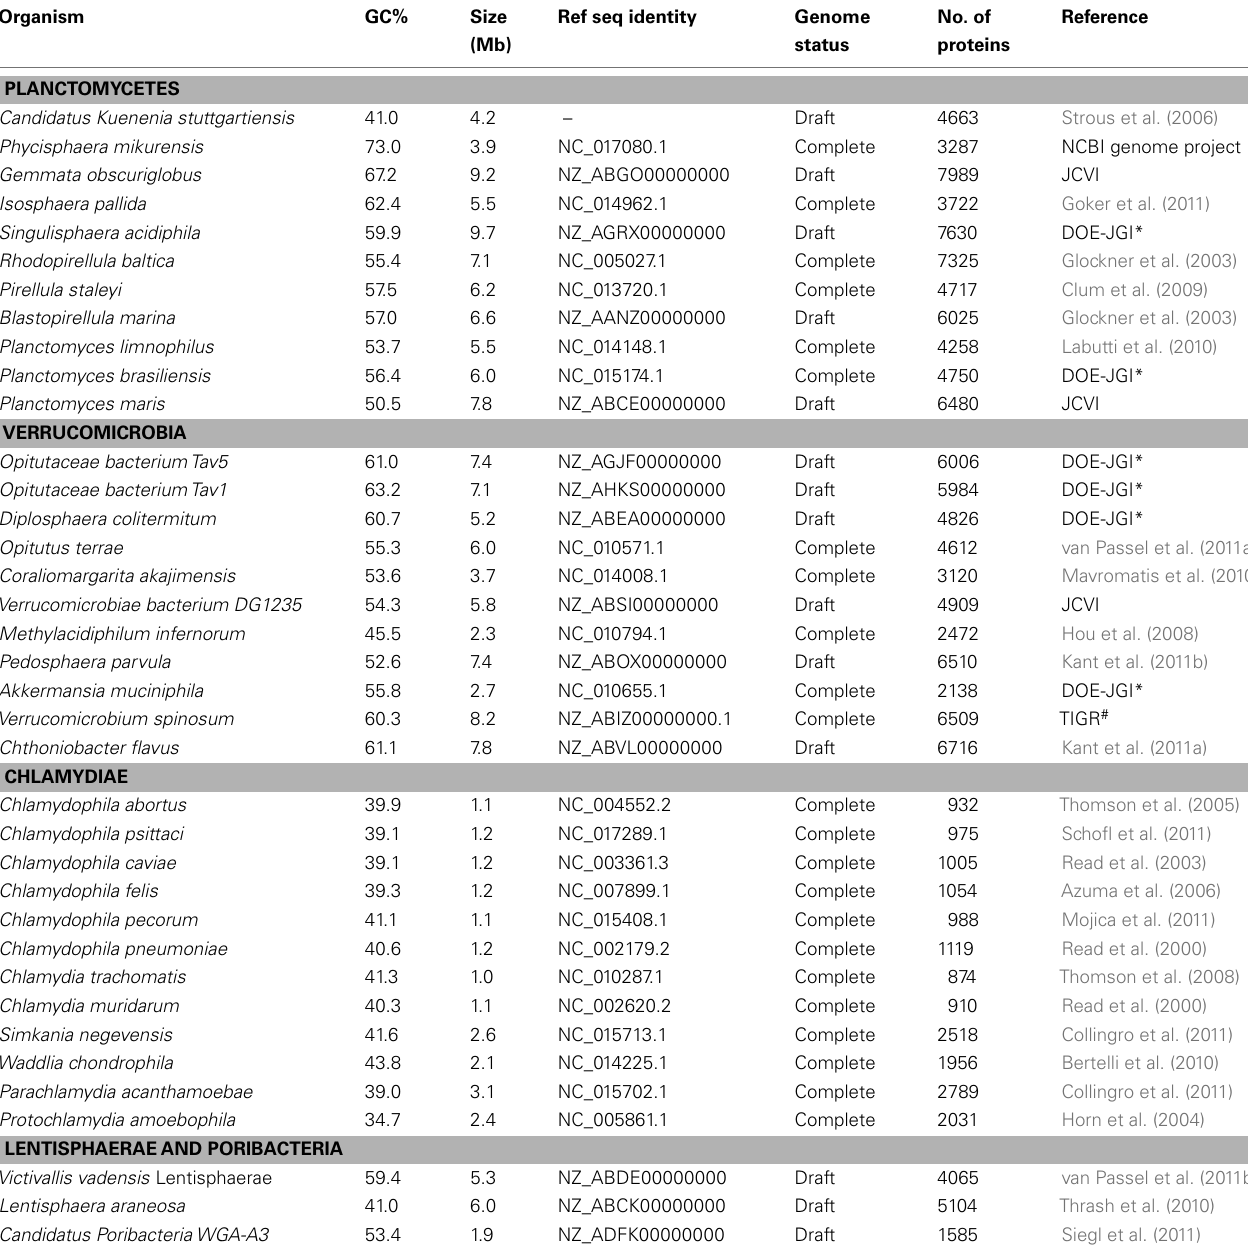
Table 1 | Some characteristics for sequenced species of the PVC group of